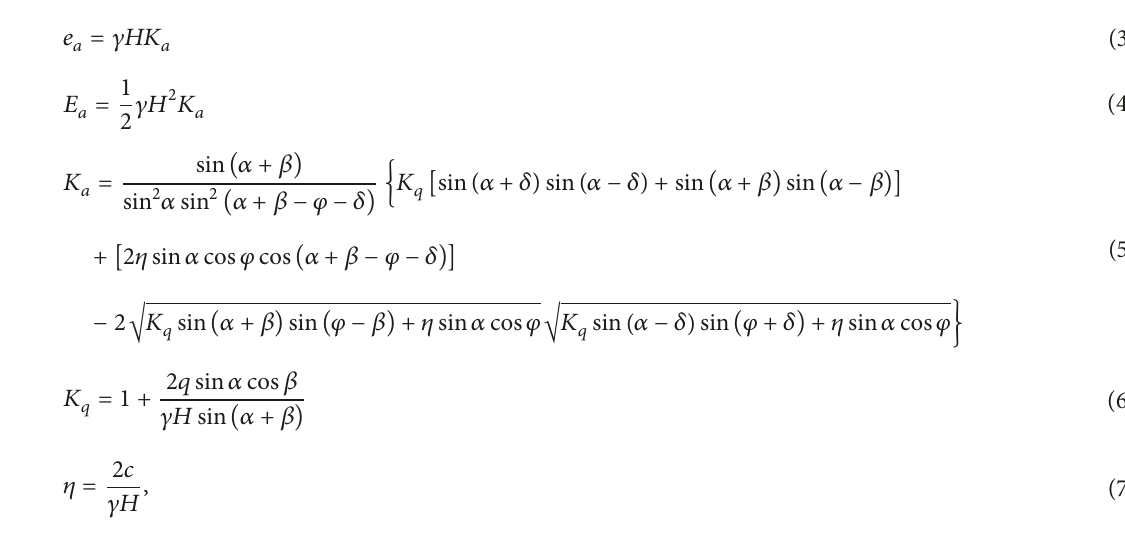
moment and the angle of inclined piles against sliding of earth pressure to decrease supporting internal force of